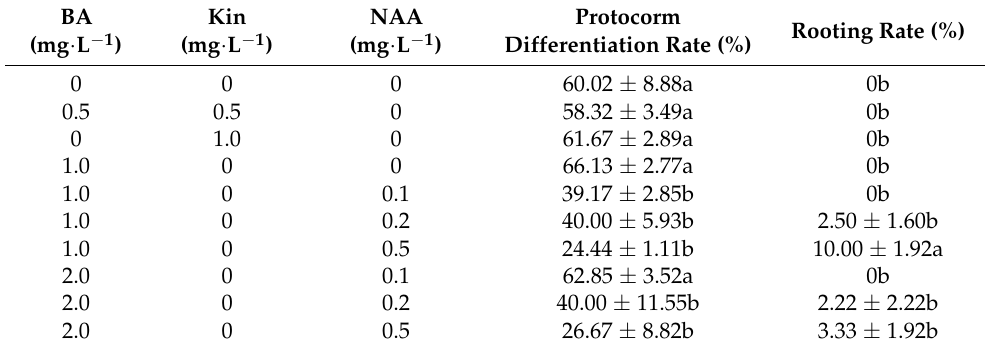
Table 5. Effect of plant growth regulators on protocorm differentiation of Paphiopedilum tigrinum . The basal medium was 1/4 MS medium supplemented with 100 mL·L −1 coconut water. Data are BA